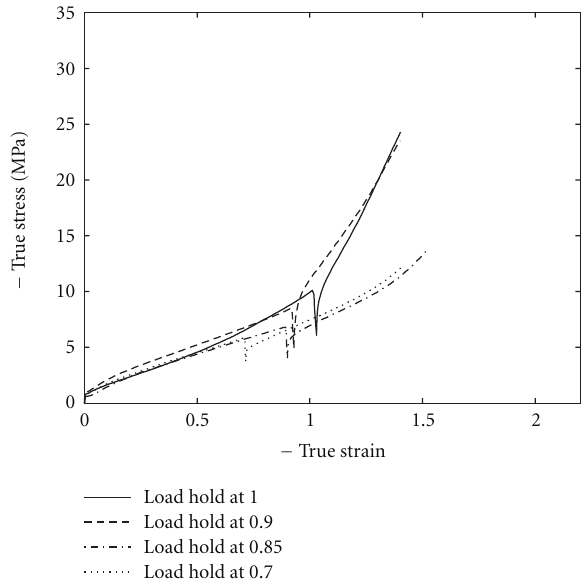
Figure 11: Stress-strain behavior of PET3.5 at 90 ◦ C and 0.1/s, plane strain compression with di ff erent hold